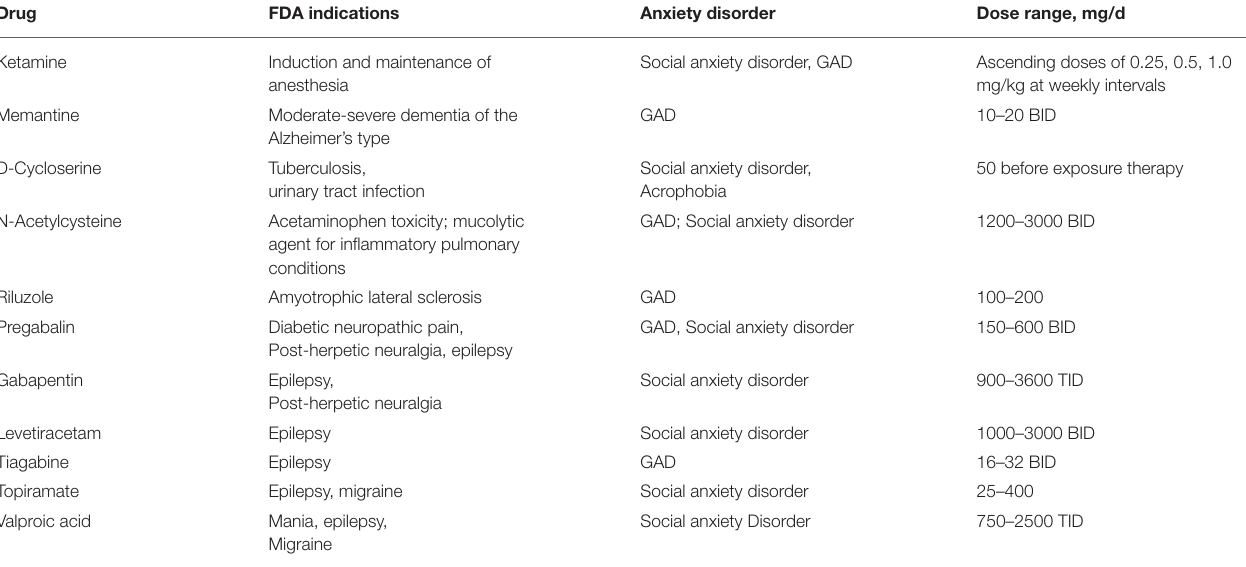
TABLE 2 | Lists the FDA approved indications of the agents and the anxiety disorders they have been tested for.